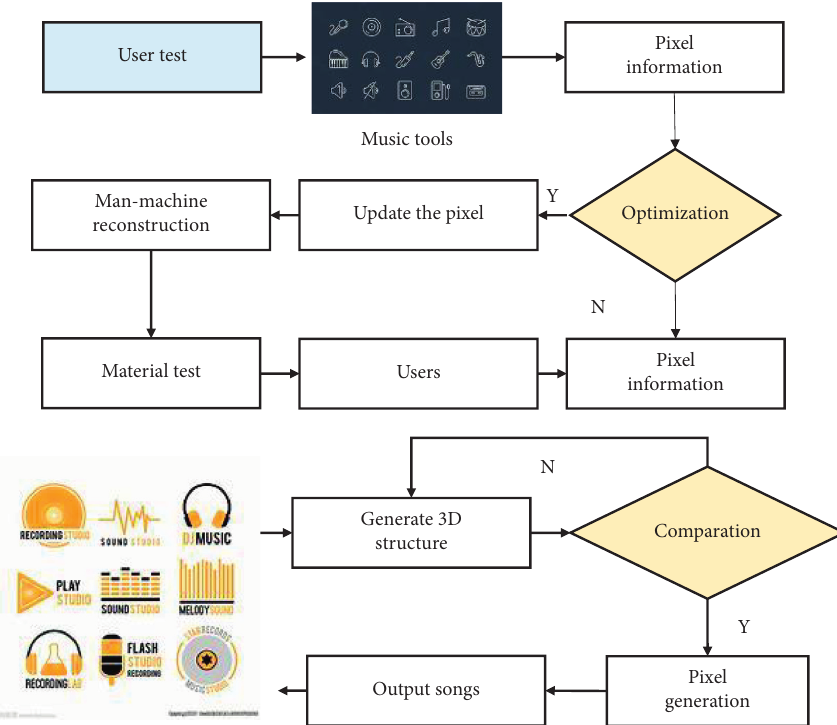
Figure 4: Music browsing class